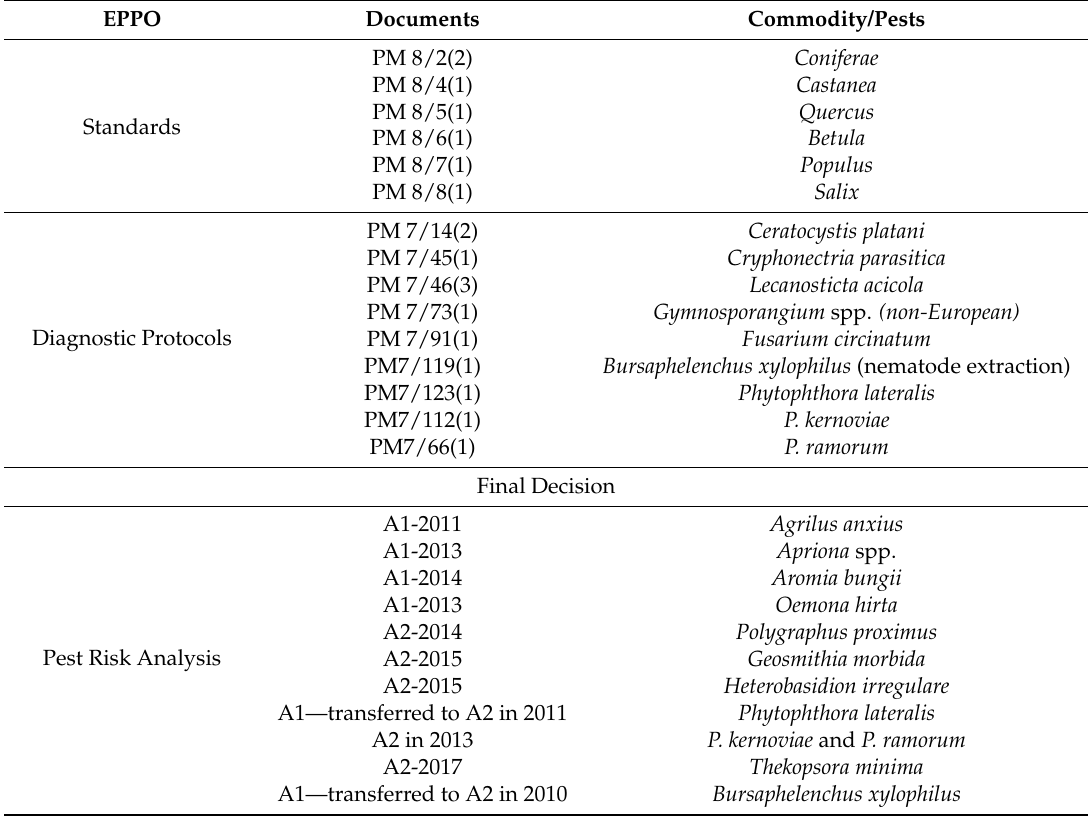
Table 1. Documents produced by the European and Mediterranean Plant Protection Organization (EPPO) related to forest pests and commodity